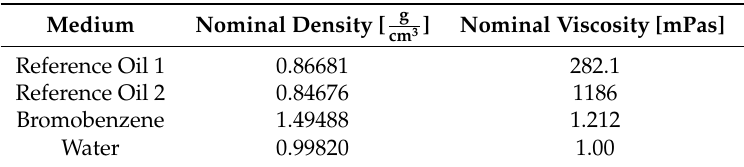
Table 1. Media reference